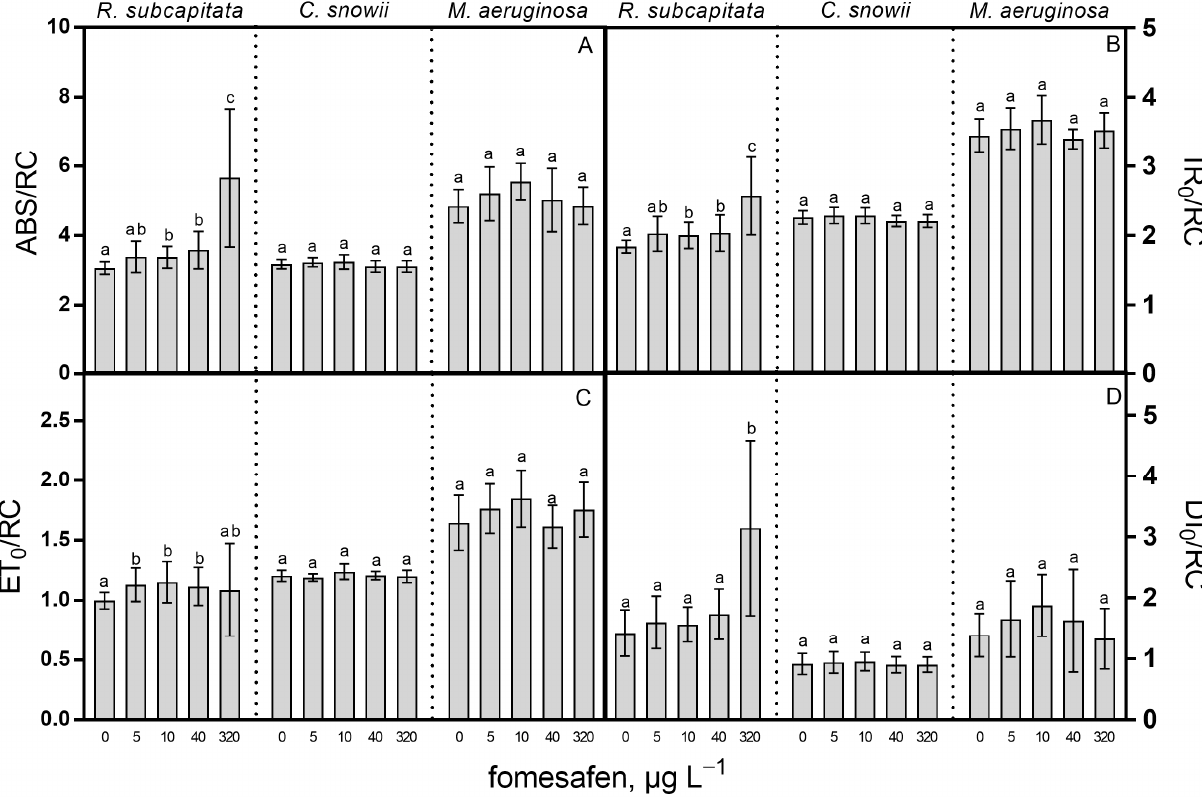
Figure 3. ( A ) ABS/RC (effective antenna size per active reaction center (RC)), ( B ) TR 0 /RC (trapped energy flux per RC), ( C ) ET 0 /RC (electron transport flux per RC), and ( D ) DI 0 /RC (effective dissipation of an active RC) of R. subcapitata , C. snowii and M. aeruginosa after 72 h exposure to five concentrations of fomesafen-based herbicide (Reflex ® ; 0, 5, 10, 40 and 320 µ g · L − 1 fomesafen a.i.). Bars indicate the means ± standard deviation of nine replicates. Means followed by the same letter are not significantly different by the Tukey–Kramer HSD test or the Kruskal–Wallis test on ranked means. The relative energy dissipation pathways of R. subcapitata, C. snowii and M. aeruginosa